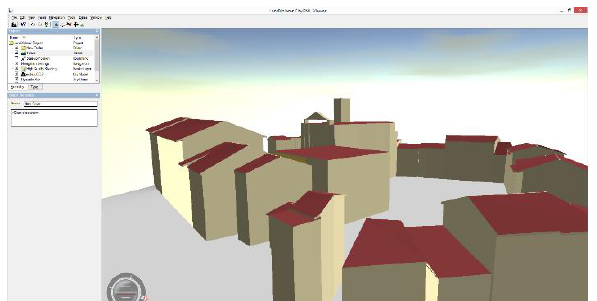
Figure 3. LOD 2Build Buildings loaded in LandXplorer